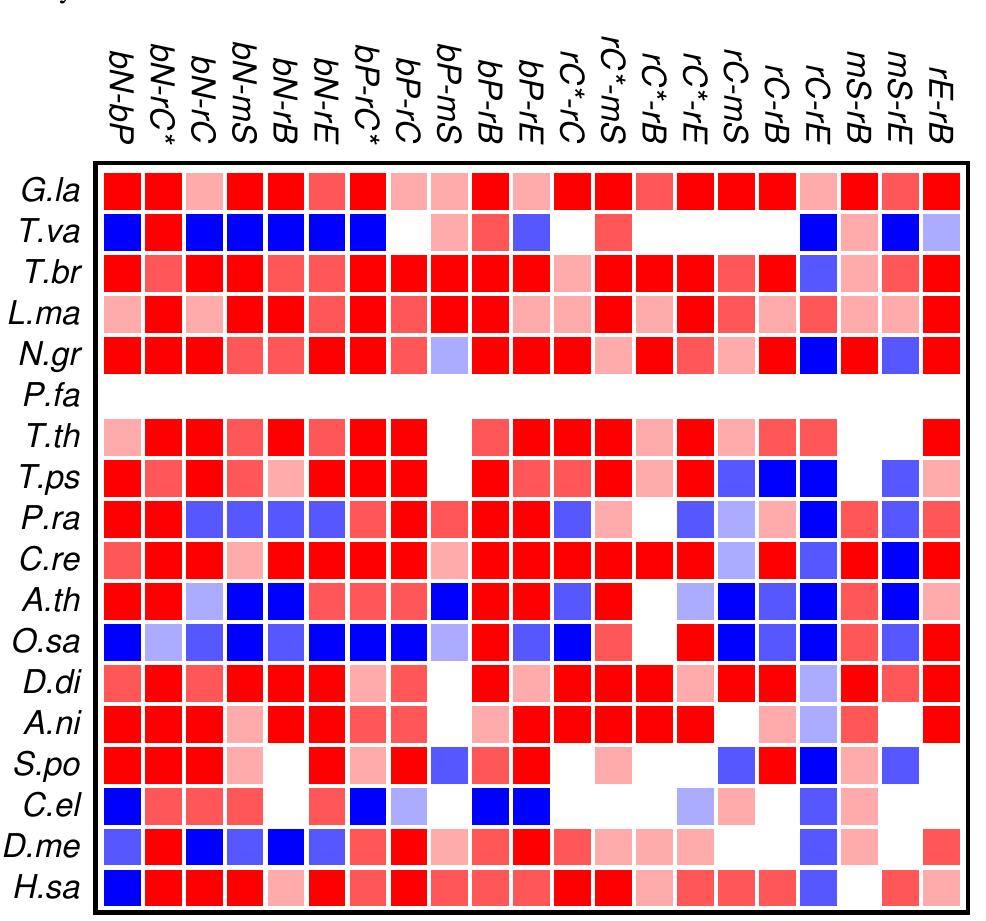
Figure 2. Summary of domain co-occurrences in 18 eukaryotic genomes. Colors indicate the statistical significance of co-occurrence n ( C ; D ) ≫ E ( C|D ) (red) and of avoidance n ( C ; D ) ≪ E ( C|D ) (blue). Significance levels on individual comparisons are shown in three levels of color saturation for p < 0 : 001 , 0 : 001 ≤ p < 0 : 01 , and 0 : 01 ≤ p < 0 : 1 , respectively. See section 3.2 for the abbreviations of the function